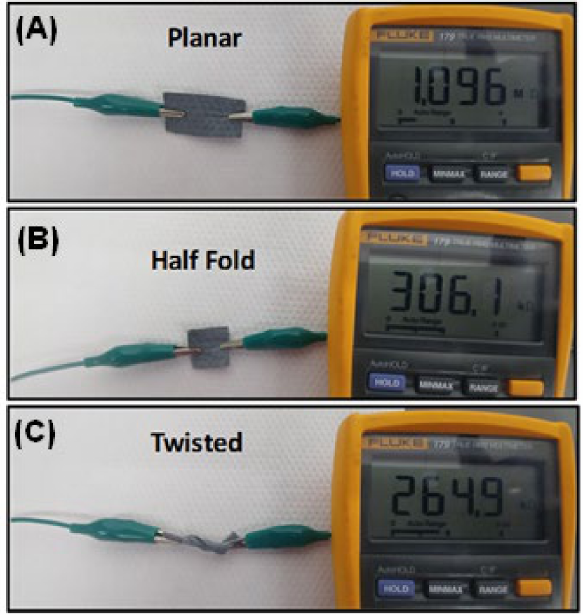
Figure 6. Polymer coated fabric in ( A ) planar: 1.096 M Ω ( B ) half fold: 306.1 k Ω and ( C ) twisted conformations: 264.9 k Ω